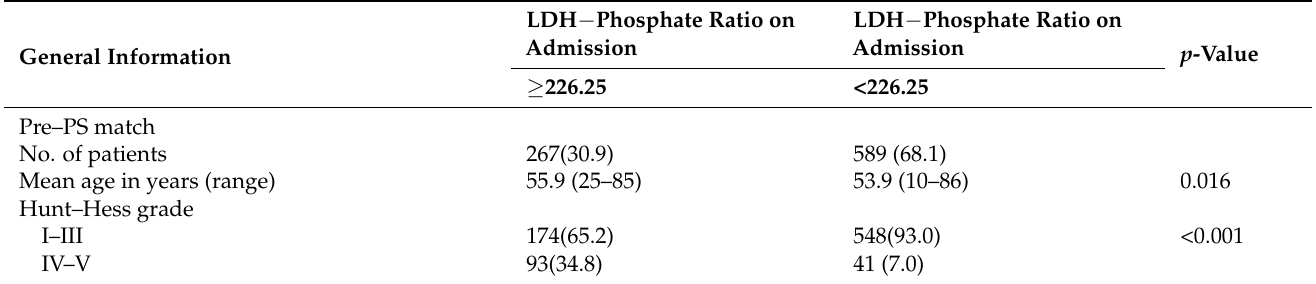
Figure 7. The mRS scores at 3 months for rIA patients with LDH to phosphate ratio ≥ 226.25 versus < 226.25 after PSM. (see Table 3 for a detailed description). ( A ). Proportions of patients within each mRS score category on the 7-point scale (where o indicates no symptoms and 6 indicates death) at 3 months between patients with LDH to phosphate ratio ≥ 226.25 versus < 226.25. ( B ). Distribution of functional outcomes at 3 months between patients with LDH to phosphate ratio ≥ 226.25 versus < 226.25. Table 4. Characteristics of rIA patients dichotomized to the LDH-phosphate ratio threshold (226.25) before and after PS